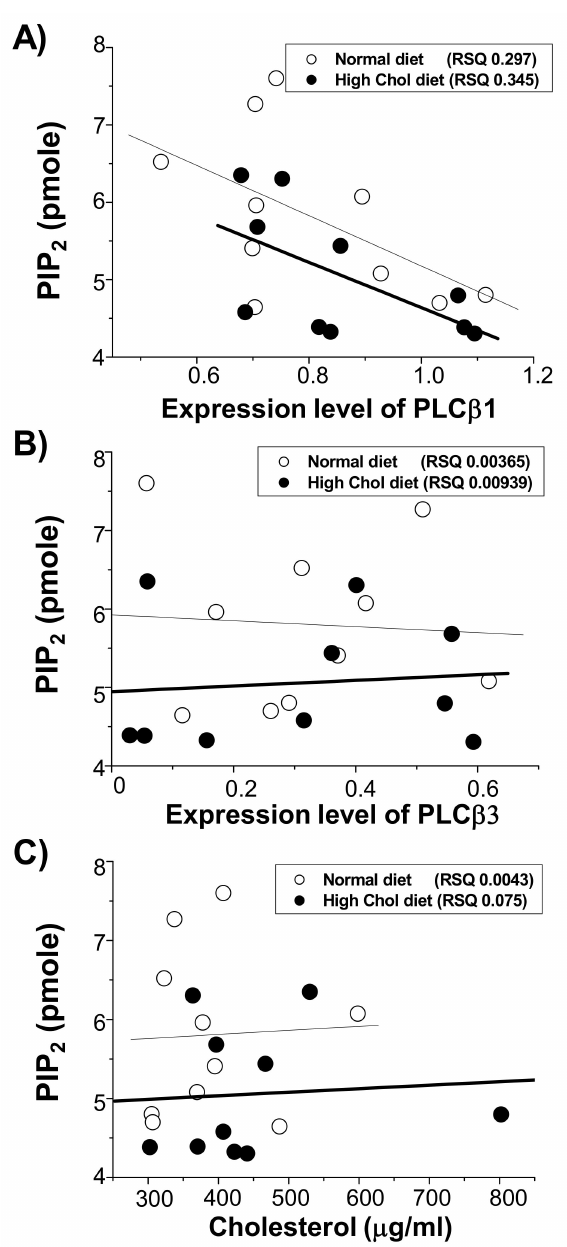
Figure 3. PIP 2 levels correlated with the PLC β 1 expression levels in the rat cerebral cortex. PIP 2 levels, PLC β 1 expression levels, PLC β 3 expression levels, and cholesterol levels from Figures 1 and 2 were re-plotted. Linear regressions were performed to obtain RSQ values from rats on normal diet (open symbols and a thin line), and from rats on a high-cholesterol diet (closed symbols and thick line). ( A ) PIP 2 levels correlated with the PLC β 1 expression levels. ( B ) There was no correlation between PIP 2 levels and PLC β 3 expression levels. ( C ) There was no correlation between PIP 2 levels and cholesterol